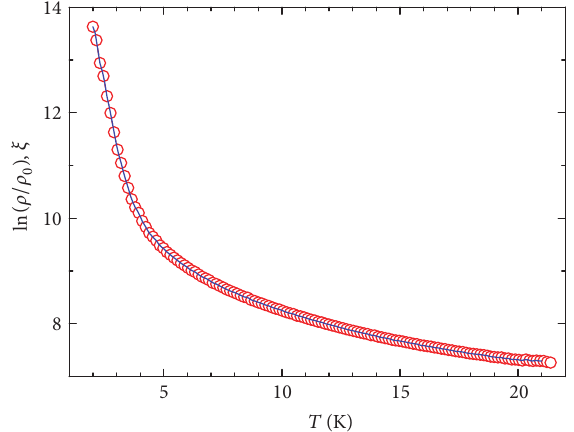
Figure 11: Experimental (symbols) ln [𝜌(𝑇)/𝜌 0 ] and calculated (lines) according to (12) 𝜉(𝑇) dependencies.